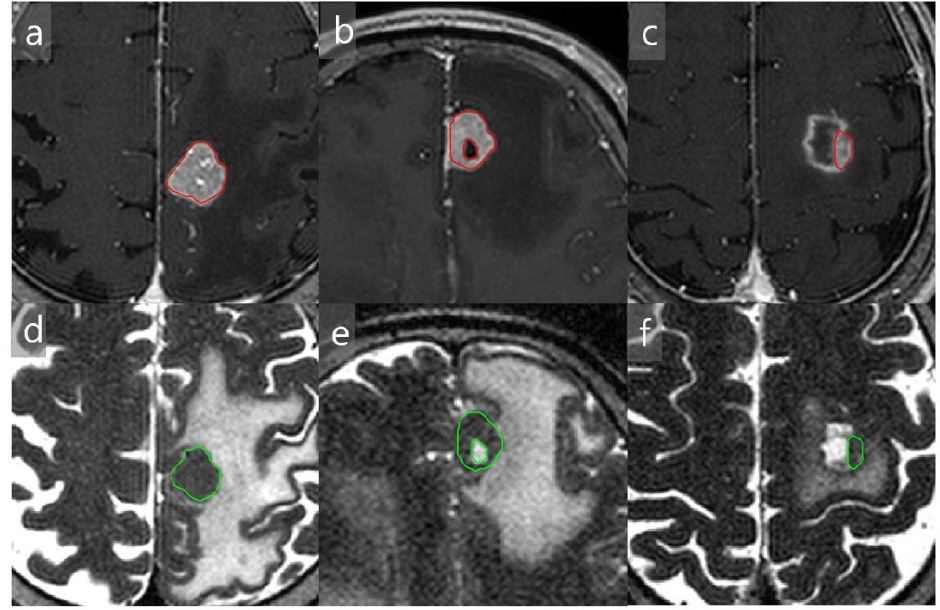
Figure 2. Examples of tumor segmentation on solid ( a , d ), predominantly solid ( b , e ), and predomi- nantly cystic ( c , f ) metastases. The regions-of-interests are drawn on contrast-enhanced T1- metastases. The regions-of-interests are drawn on contrast-enhanced T1-weighted ( a – c ) and T2-weighted ( d – f ) images for weighted ( a – c ) and T2-weighted ( d – f ) images for each lesion. each